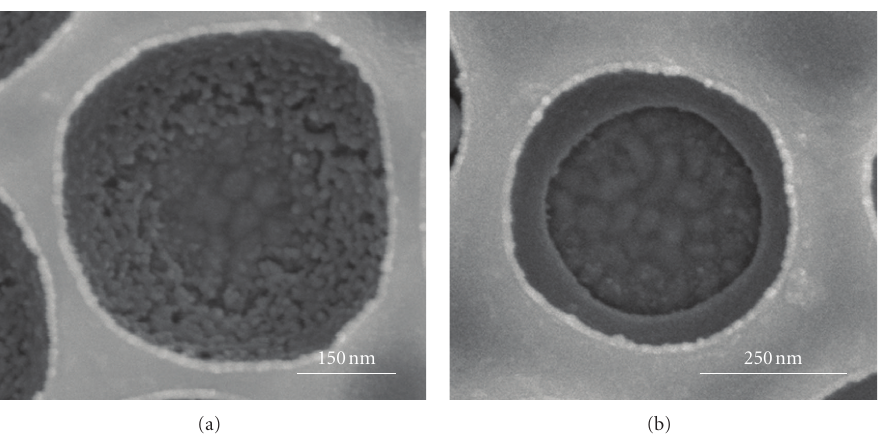
Figure 5: SEM images of (a) a narrow and (b) a wide conductive domain located at the bottom of the silica nanowells on a gold electrode. (Scale bar: (a) 150 nm, (b) 250